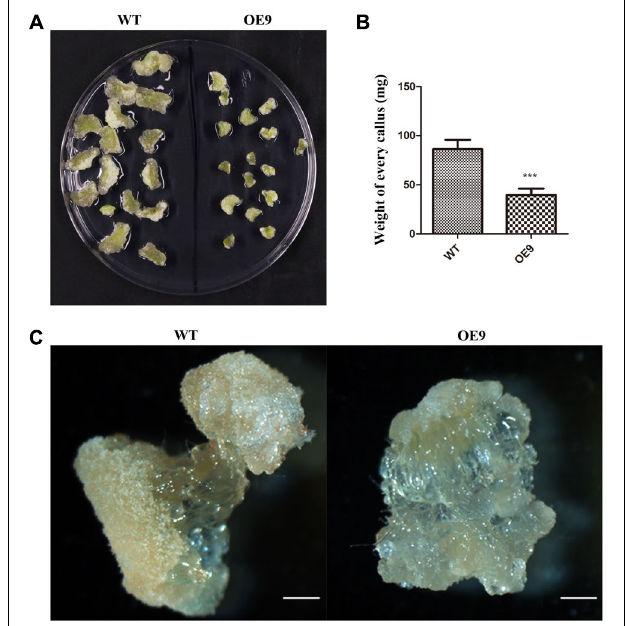
FIGURE 5 | Callus-induction assay of tobacco leaf and petiole. (A) Morphology of calli induced from top leaf of the four-leaf-stage plants after culture for 2 weeks. (B) The average fresh weight of calli in (A) . The values represent the mean ± SD from 60 calli and the statistically significant differences were evaluated by Student’s t -test ( ∗∗∗ P -value < 0.001). (C) The calli induced from second petioles of the four-leaf-stage plants after culture for 2 weeks. OE9 showed smaller callus. Scale bar: 1 mm in (C)